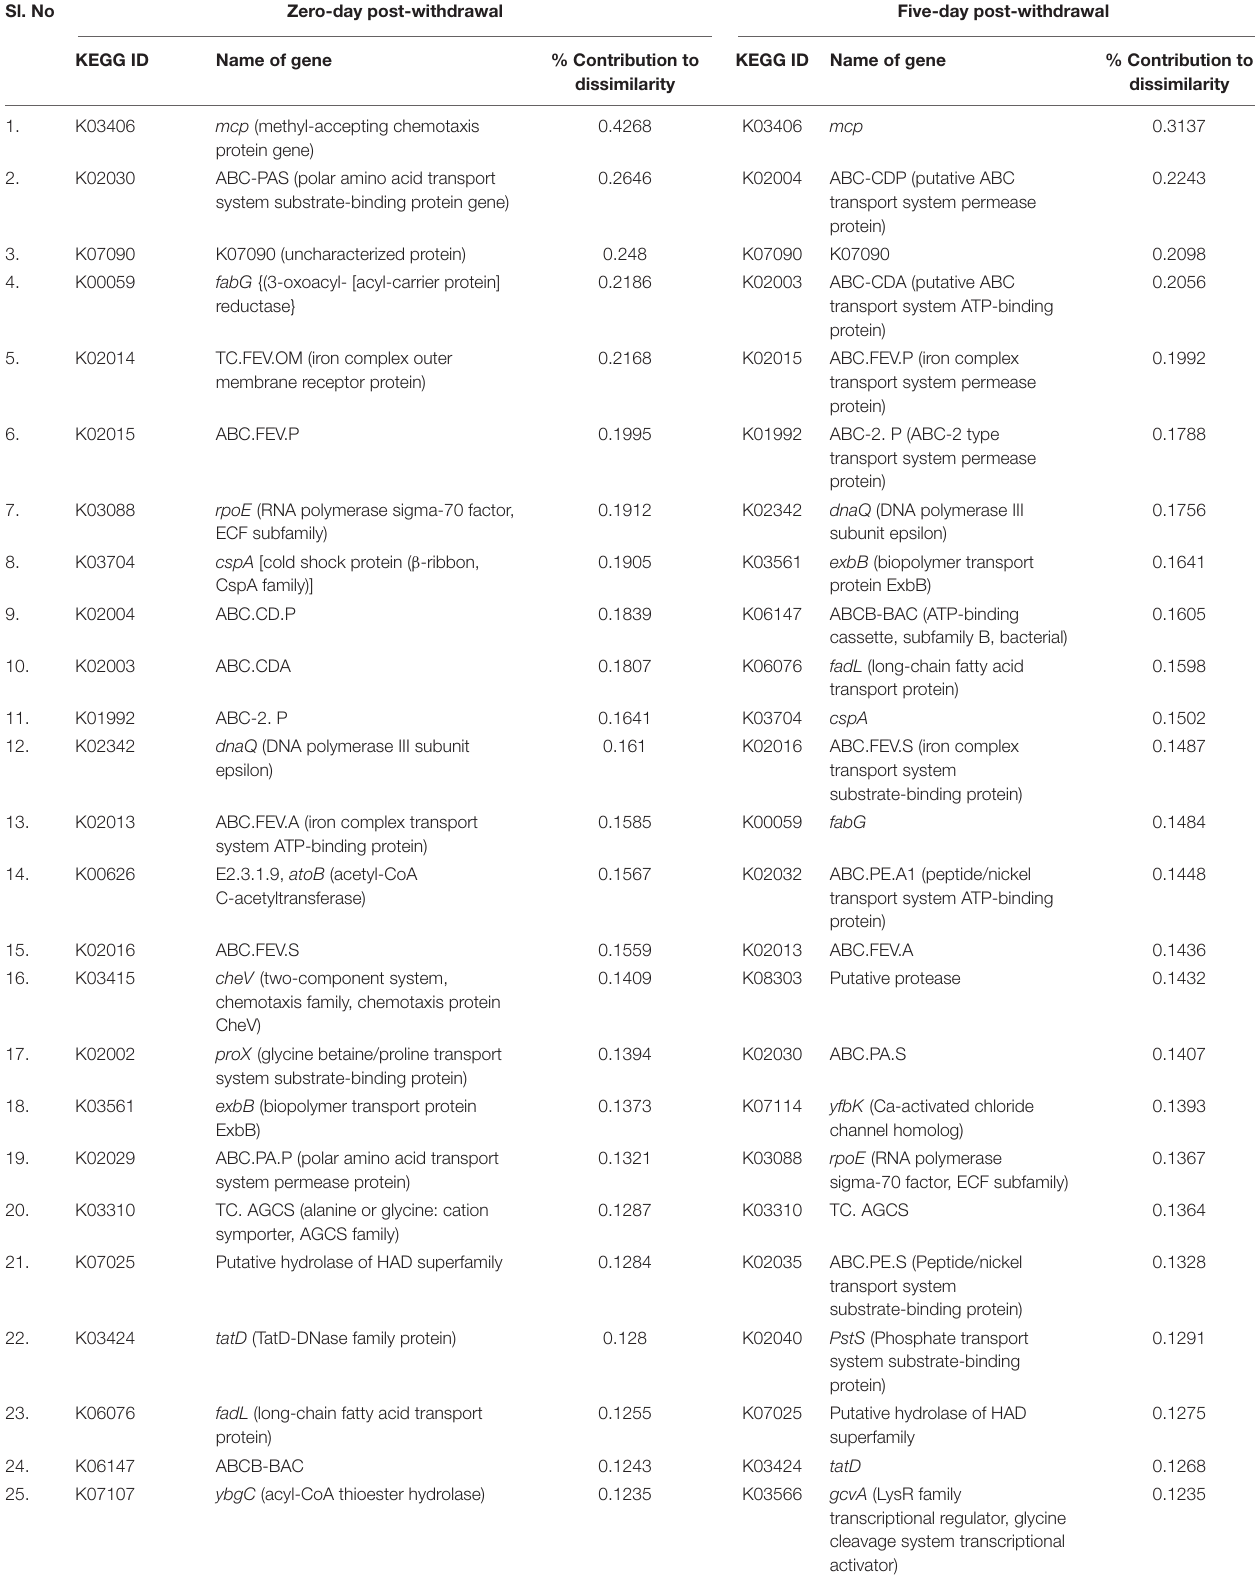
TABLE 2 | Details of KEGG genes whose abundances were significantly different compared to the control fish. Sl.